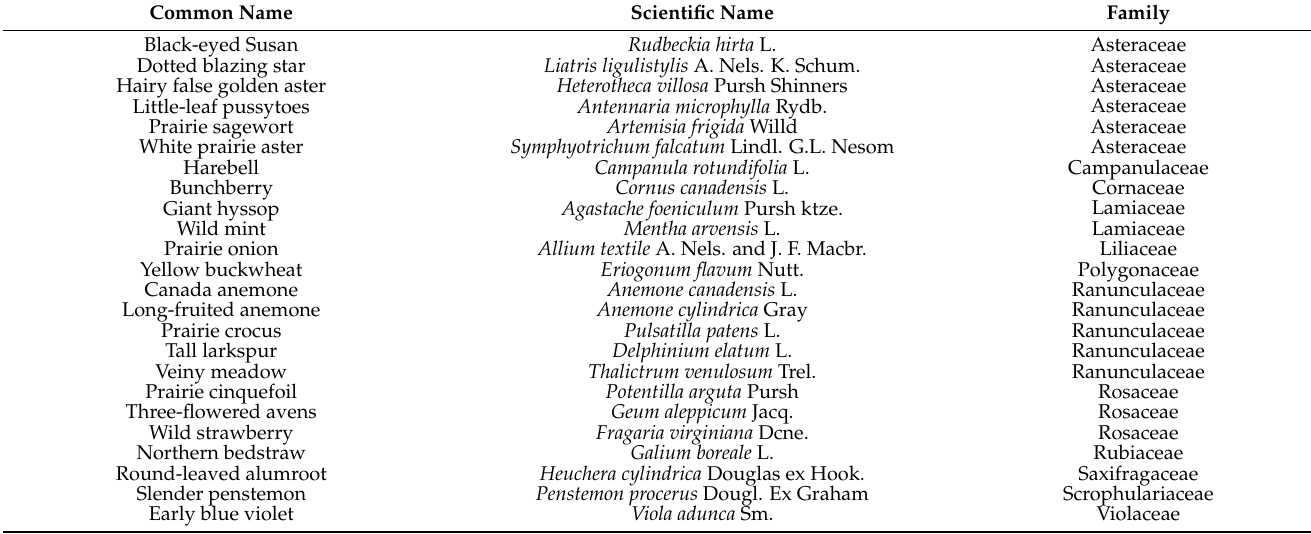
Table 1. Planted native forb